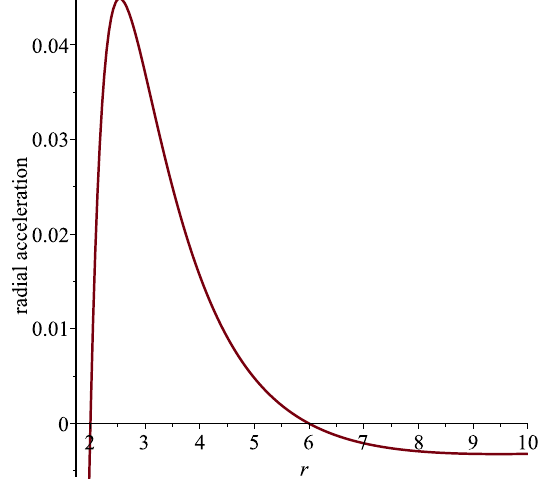
Figure 2. Behaviour of ¨ r in the Schwarzschild geometry when using Schwarzschild curvature coordinates for m = 1 and (cid:101) = 1. Note the curve crosses the r axis at both r = 2 and r = 6; the coordinate acceleration is positive between the horizon and the